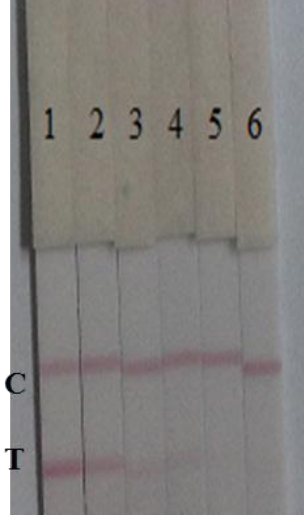
Figure 4. The detection of Pss by immunochromatographic strip. The concentration was as follows: (1) 1 × 10 7 , (2) 3.3 × 10 6 , (3) 1 × 10 6 , (4) 3.3 × 10 5 , (5) 1 × 10 5 cfu/mL and (6) blank. T, test line. C, control